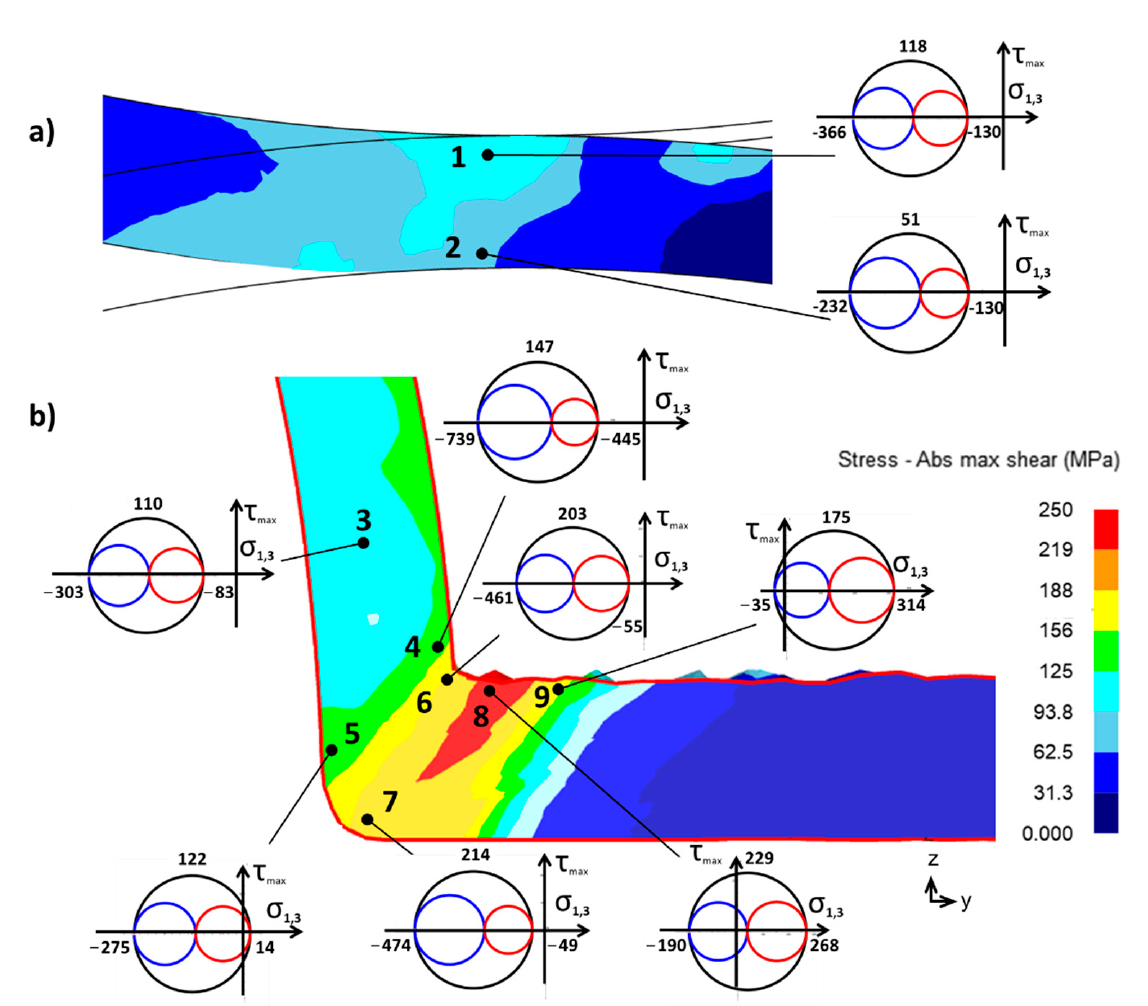
Figure 8. The stress state analysis of the ECAR process in: ( a ) Shape Rolling zone (points 1, 2); ( b ) part of the Upsetting zone (point 3), and SPD zone (points 4–9). Upsetting (zone B) it can be characterized as a secondary gripping zone. There is gradual increase in contact stress between the billet and groove wall from the point at which yielding occurs up to the point at which shearing deformation of the billet occur. The gradual filling of the channel also increases the contact pressure between the billet and